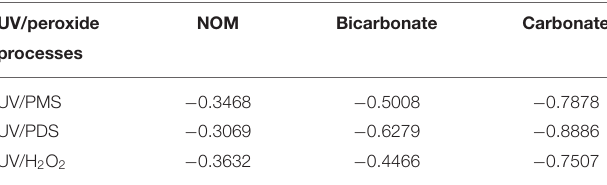
TABLE 3 | Relative differences of removal efficiencies (RDRE) between UV/peroxide processes and UV/peroxide processes in the presence of additives (radical